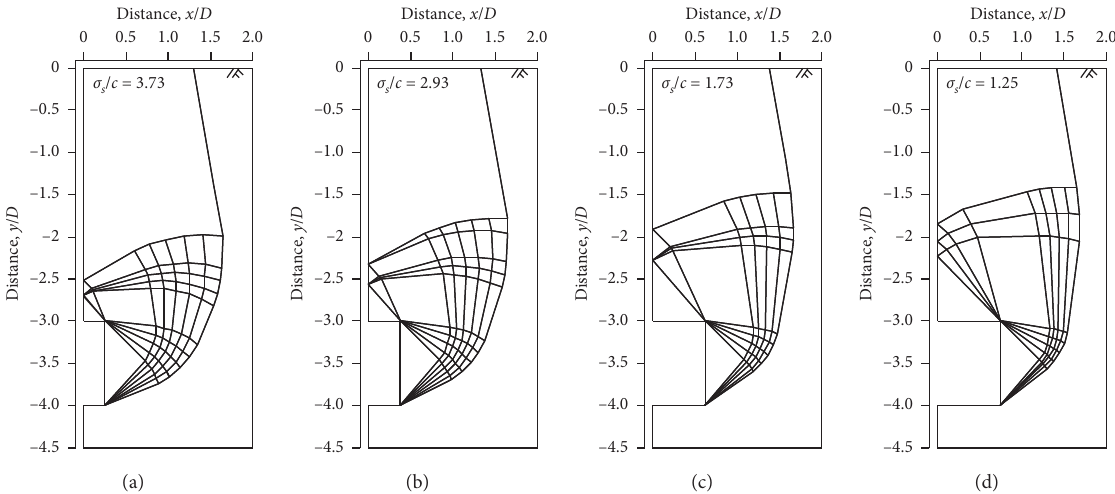
Figure 5: Variation in the failure mechanisms with B/D for φ � 10 ° , H/D � 3, and c D / c � 1. (a) B / D � 0.5. (b) B / D � 0.75. (c) B / D � 1.25. (d) B / D �